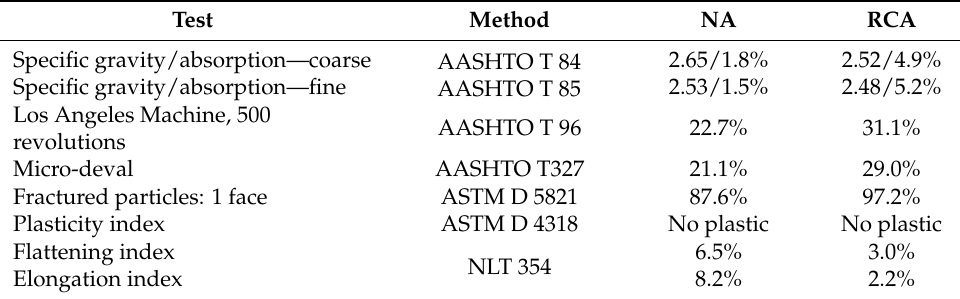
Table 2. Properties of NA and RCA particles.